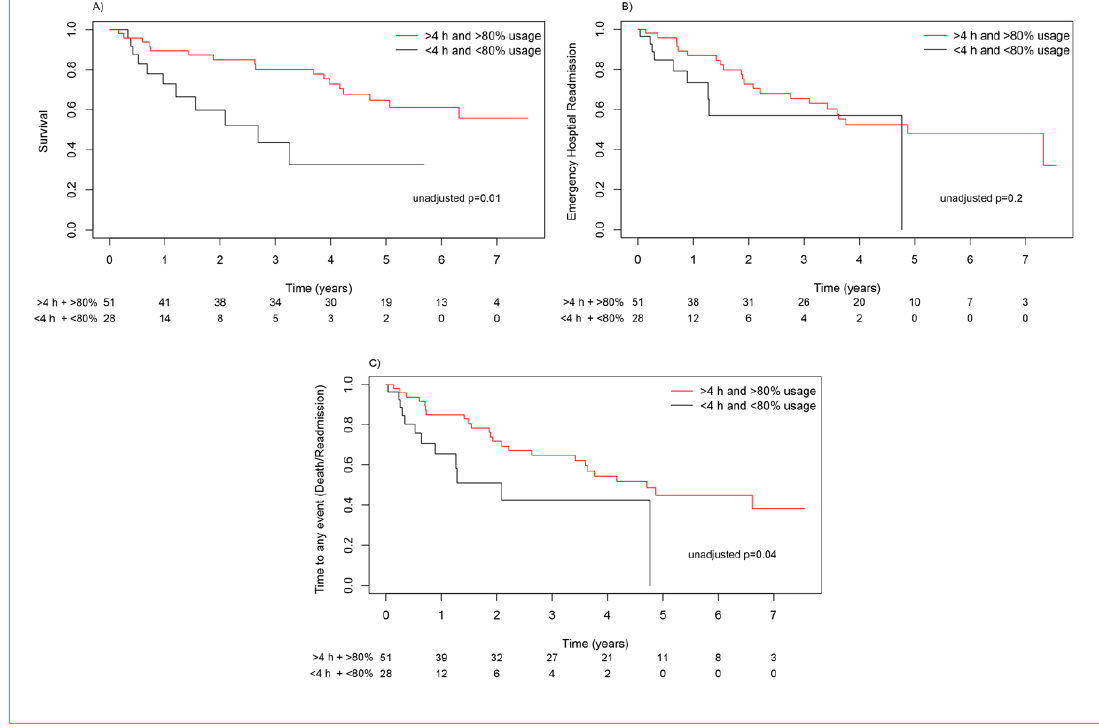
Figure 3: Kaplan-Meier curves for survival (A), emergency hospital readmission (B) and time to any event (death, readmission) (C) according to usage of the